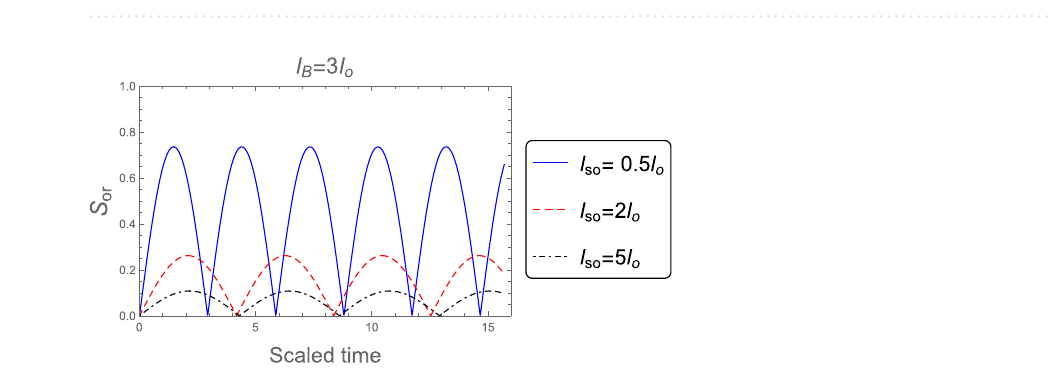
Figure 2. As Fig. 1, but when the weak magnetic field l B